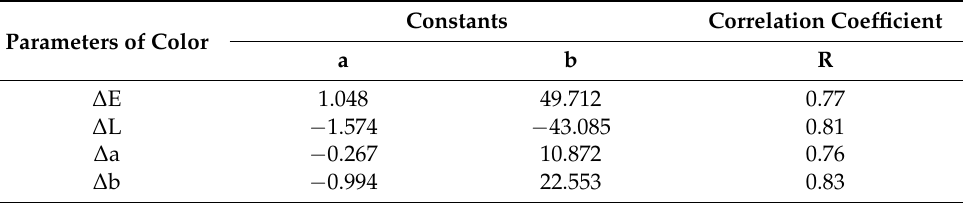
Table 2. Constants in the regression equation y = ax + b relating parameters of color to time of heat treatment.